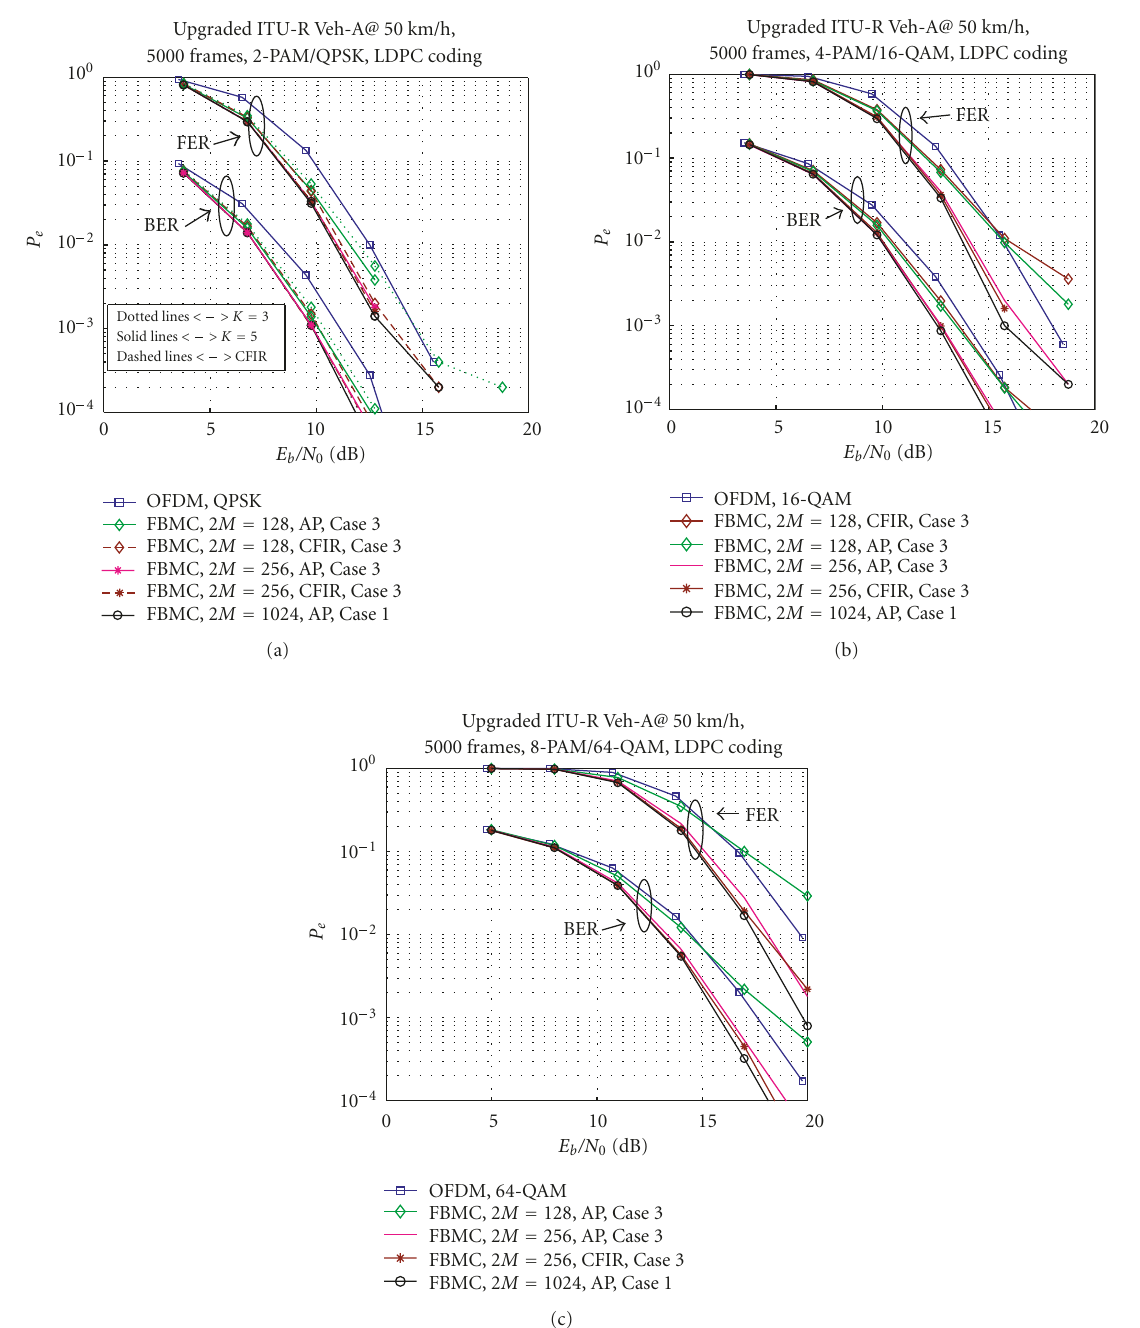
Figure 11: Coded FER and BER performance: (a) 2-PAM/FBMC and QPSK/OFDM; (b) 4-PAM/FBMC and 16-QAM/OFDM; and (c) 8- PAM/FBMC and